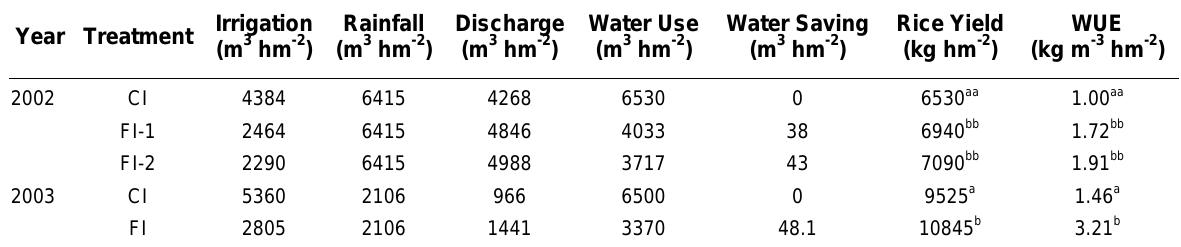
A Comparison of Water Use and Rice Production using the CI, FI-1, and FI-2